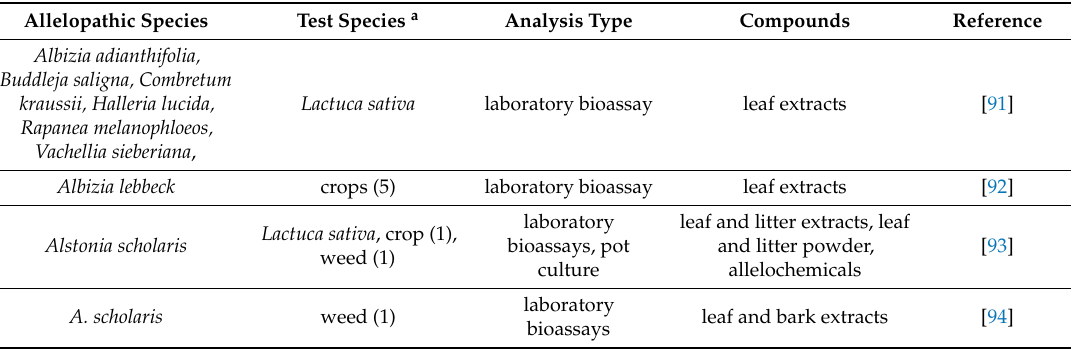
Table 1. Allelopathy of angiosperm tree